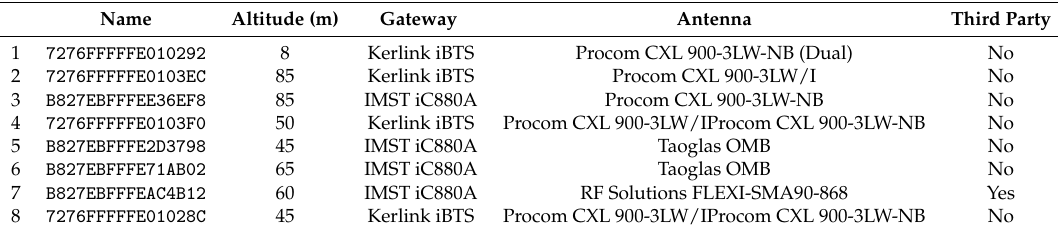
Table 5. LoRaWAN base stations located in the city of Southampton, including third party hardware. The Kerlink iBST supports antenna diversity but not all are equipped with dual